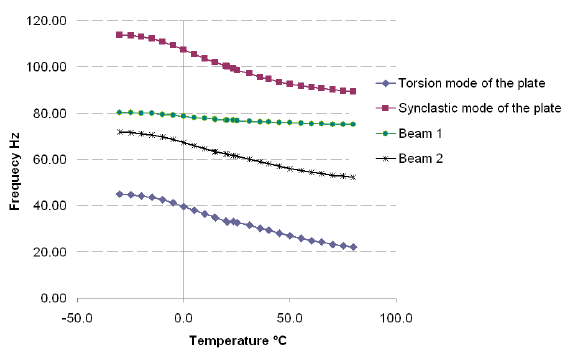
Fig.6. Measured natural frequencies as a function of the temperature.